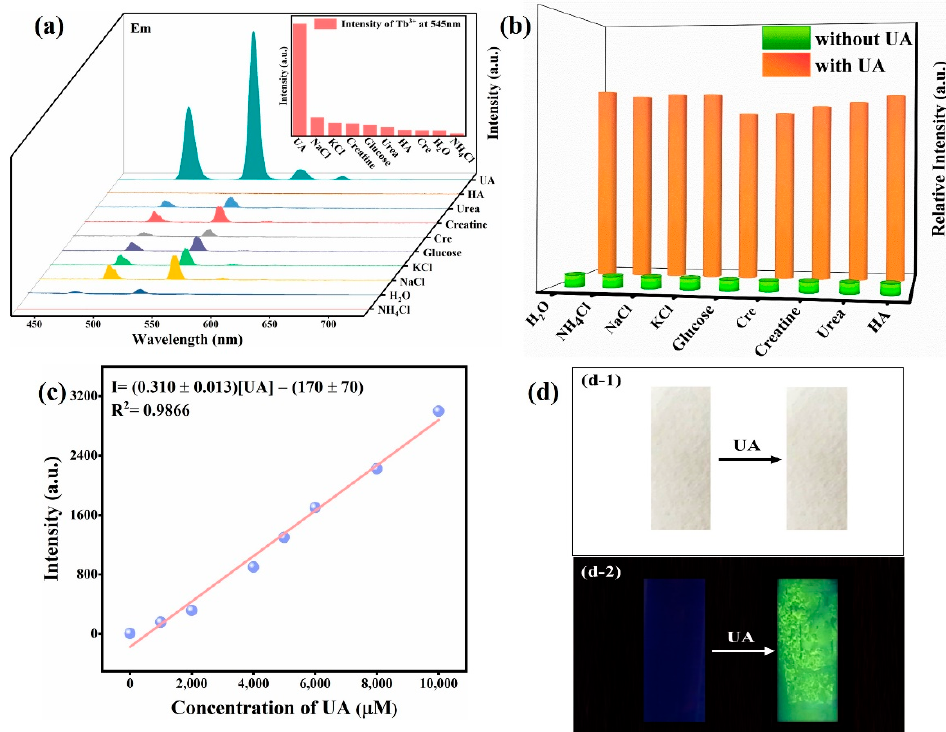
Figure 2. ( a )The emission spectra of Cu 2+ @Tb-MOFs sample materials immersed in various urine composition solutions (the inset is 2D-histogram based on the intensity of 5 D 4 → 7 F 5 transition of Tb 3+ in Cu 2+ @Tb-MOFs toward various urine chemicals, λ ex = 337 nm); ( b ) The fluorescence intensity of Cu 2+ @Tb-MOFs in the presence of other components in urine (green bars), and the subsequent addition of UA (orange bars); ( c ) The linear relationship the fluorescence intensity and the concentration of UA; ( d ) Comparison of Cu 2+ @Tb-MOFs test paper for uric acid recognition under light (d-1) and UV (d-2) irradiation.